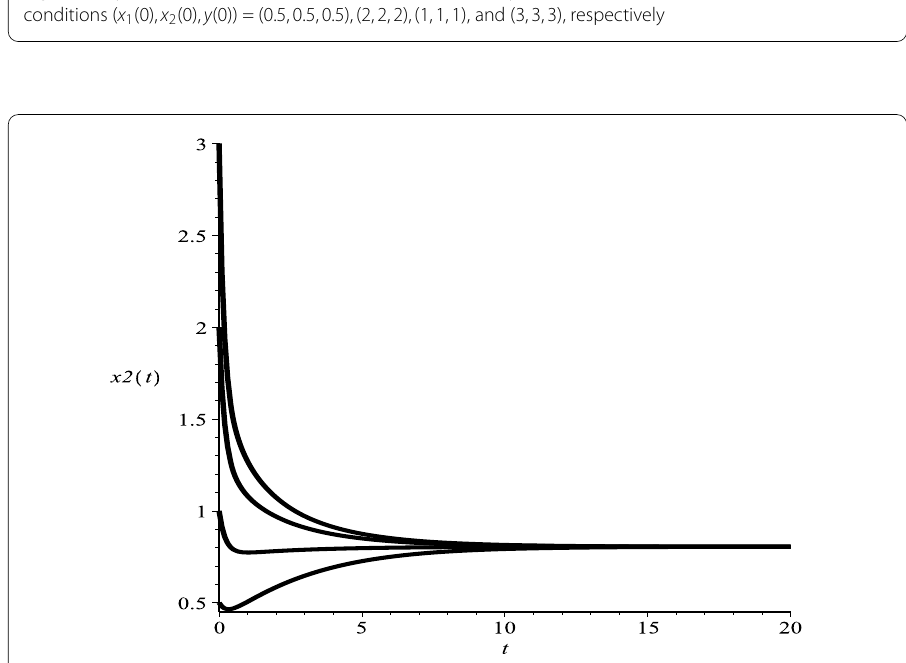
Figure 3 Dynamics behavior of the second component x 2 ( t ) of system (5.1); here we take k = 0.9 and the initial conditions ( x 1 (0), x 2 (0), y (0)) = (0.5,0.5,0.5),(2,2,2),(1,1,1), and (3,3,3),